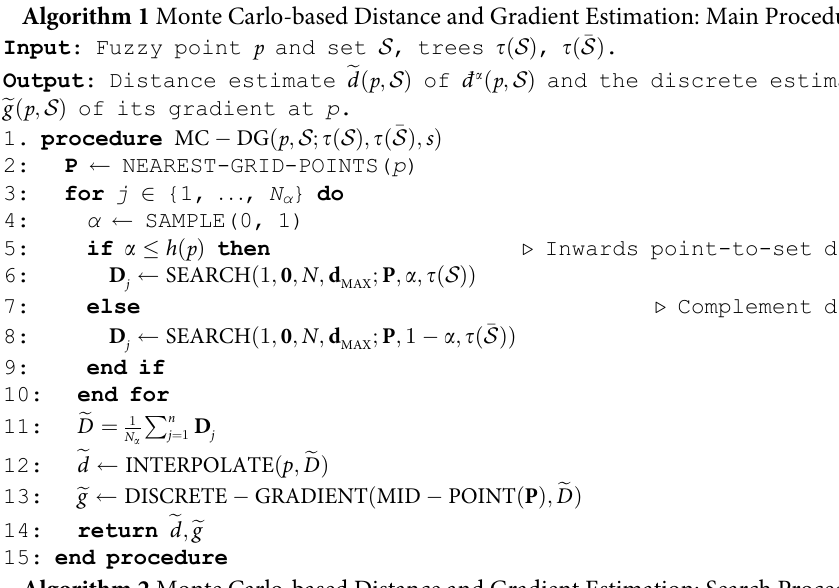
Algorithm 1 Monte Carlo-based Distance and Gradient Estimation: Main Procedure